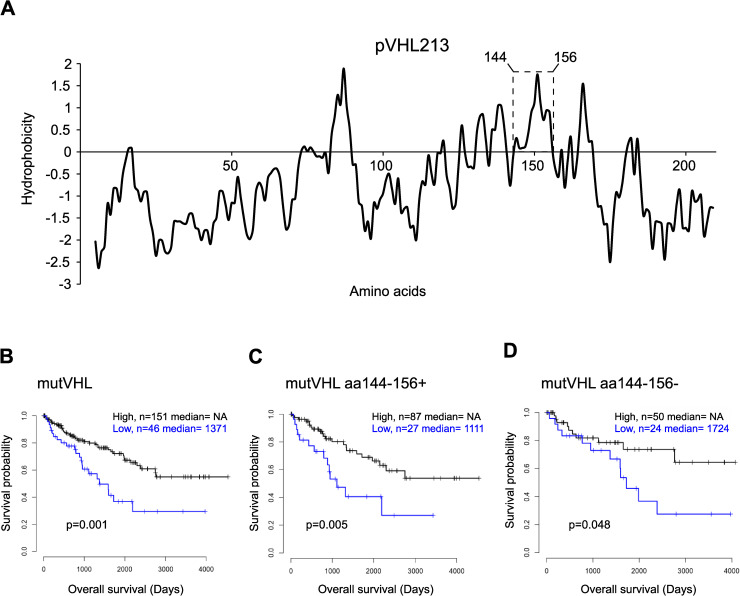
Expression levels of PFDN3 correlates with survival of ccRCC patients with mutated VHL.A) Kyte-Doolittle hydrophobicity plot for the whole pVHL213 protein, dashed inset shows the aa144-156 hydrophobic peak, B-D) Analyses by Kaplan-Meier curves to report overall survival of patients with High (grey line) or Low (blue line) PFDN3 expression levels extracted from the TCGA database: B) patients with mutated VHL (mutVHL, n = 197), C) mutVHL patients with an intact aa144-156 region (mutVHL aa144-156+, n = 114), D) mutVHL patients without aa144-156 region (mutVHL aa144-156-, n = 74). P values are indicated below the curves.